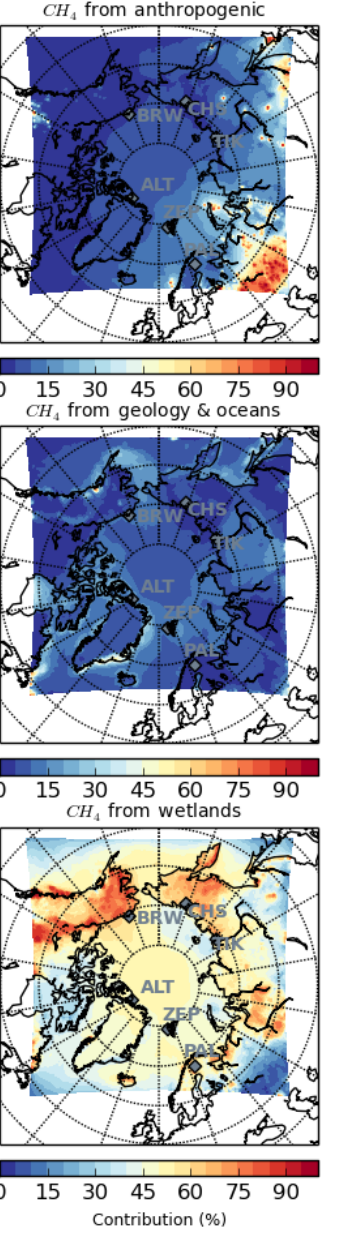
Figure 4. Mean source contributions (in %) to the CH 4 abundance (excluding CH 4 resulting from the boundary conditions) simulated by CHIMERE, at 990hPa, over June–October